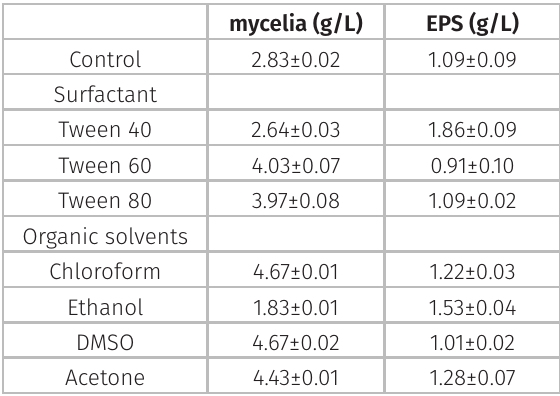
Table I. Effect of surfactants and organic solvents on mycelial growth and exopolysaccharide (EPS) production by Inonotus rickii in shake flask